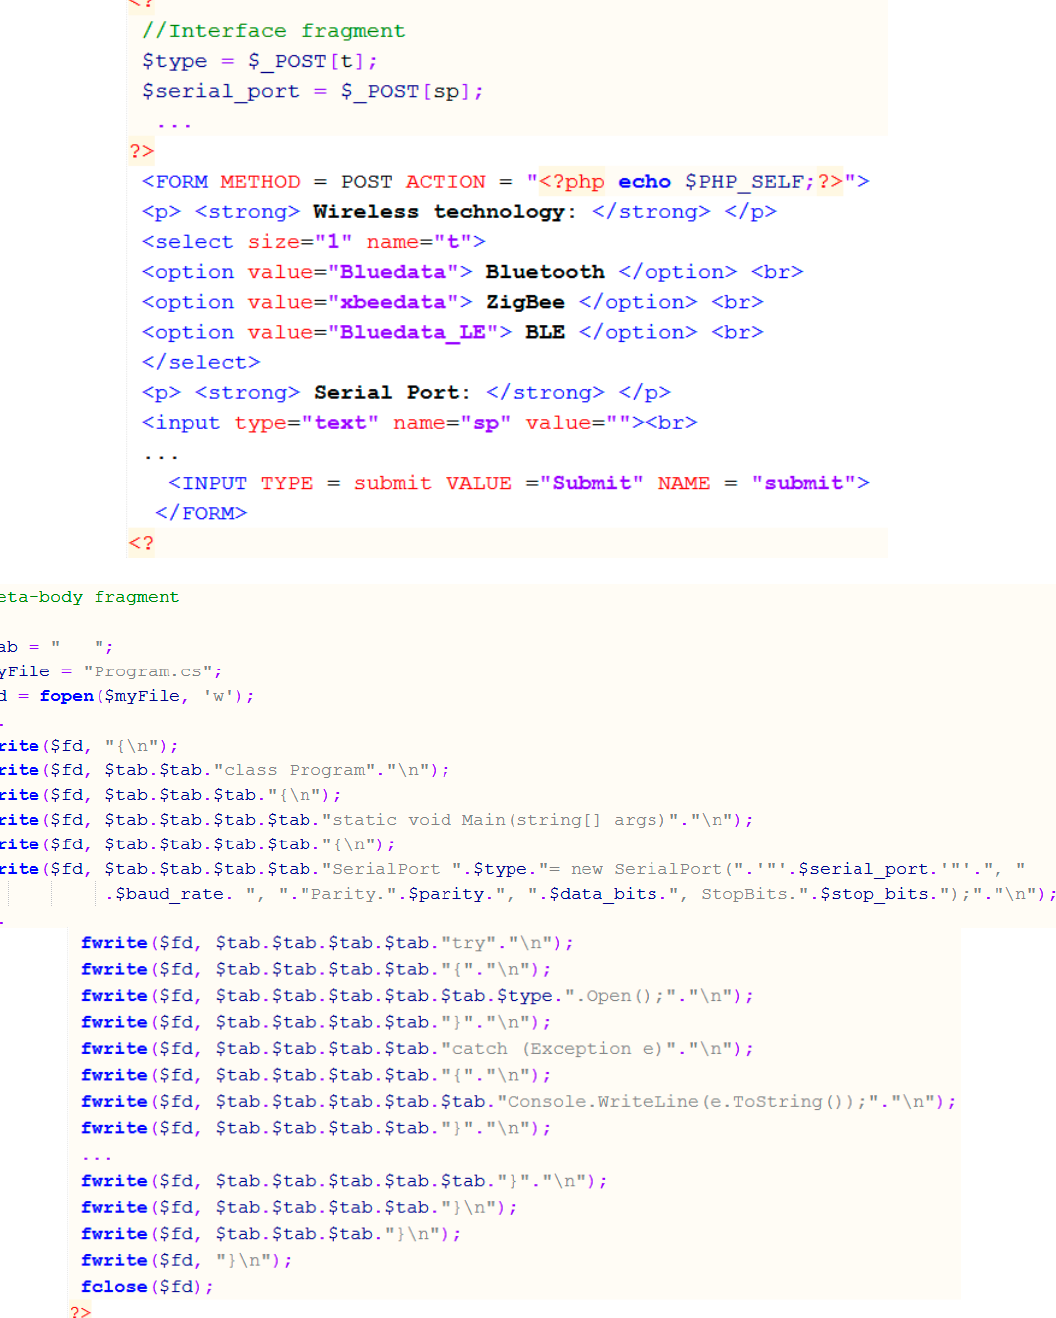
Figure A1. Meta-program fragments in PHP, using HTML for representation of parameters and their values.